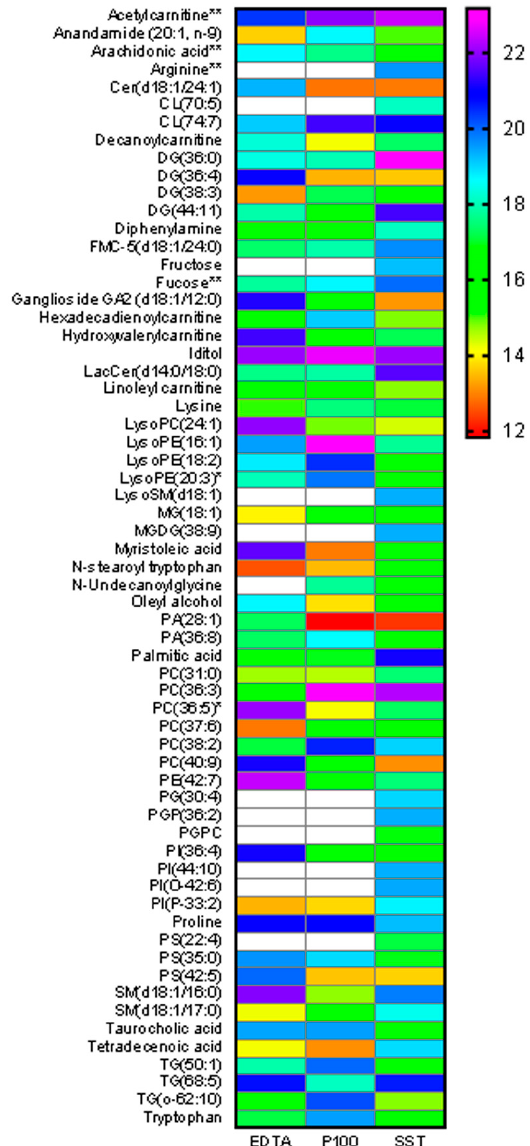
Figure 2. Abundance differences among blood collection tubes . The control tubes were compared to determine extraction differences using One-way ANOVA with Bonferroni FWER ≤ 0.05 and fold change ≥ 1.5. The database annotated metabolites are shown. ** indicates an identification with MSMS and standards, * indicates an identification with MSMS fragment match to NIST spectral library. n = 3 individuals per time point. The heatmap colors range from red (low abundance) to purple (high abundance). White indicates an abundance that was below the level of detection or filtering thresholds (missing values). Cer: ceramide, CL: cardiolipin, DG: diglyceride, PA: phosphatidic acid, PC: phosphatidylcholine, PE: phosphatidylethanolamine, PI: phosphatidylinositol, SM: sphingomyelin, TG: triglyceride.